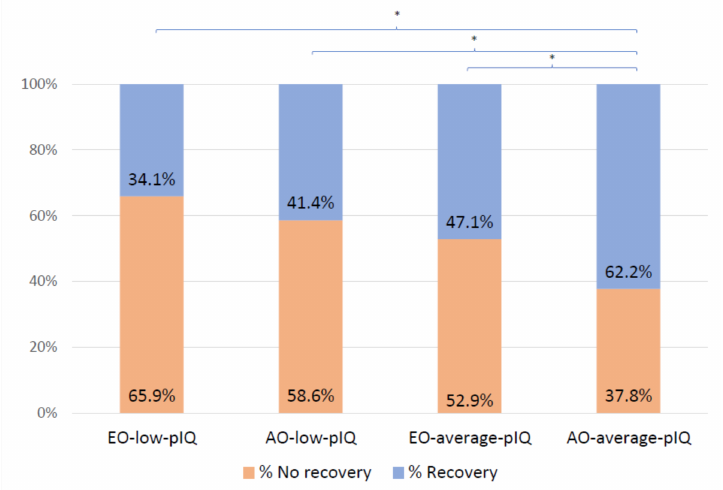
Figure 1. Recovery rates in subgroups of patients with a first episode of psychosis at two-year follow- up. EO-low-pIQ: early onset with premorbid IQ < 85. AO-low-pIQ: adult onset with premorbid IQ < 85. EO-average-pIQ: early onset with premorbid IQ ≥ 85. AO-average-pIQ: adult onset with premorbid IQ ≥ 85. * = Significant pairwise comparison p <